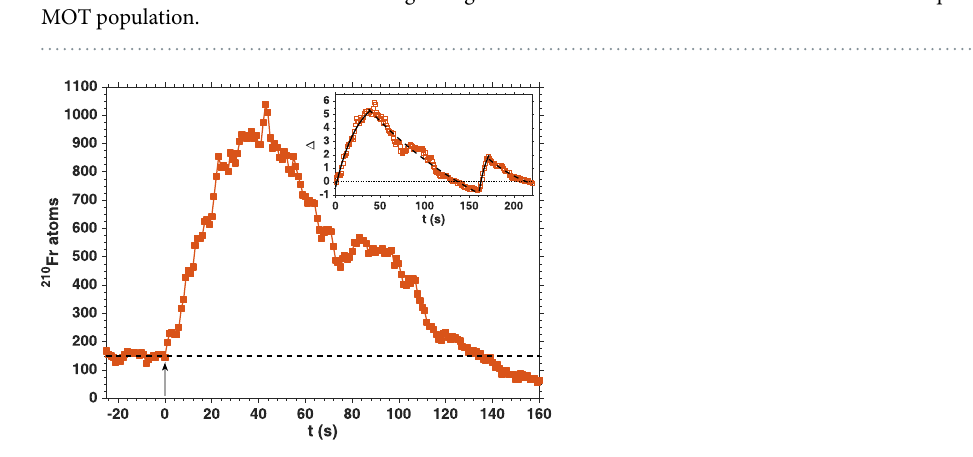
Figure 4. Charge transfer-induced desorption of 210 Fr from PDMS. 210 Fr MOT population after local charge transfer from a dielectric probe at t = 0. The horizontal dashed line indicates the MOT equilibrium population. Inset: Relative variation of the 210 Fr MOT population Δ (Equation 1) in the same experiment, with a second application at t = 161 s of the charge transfer from the dielectric probe. Continuous and dashed curves correspond to the best exponential fits of experimental